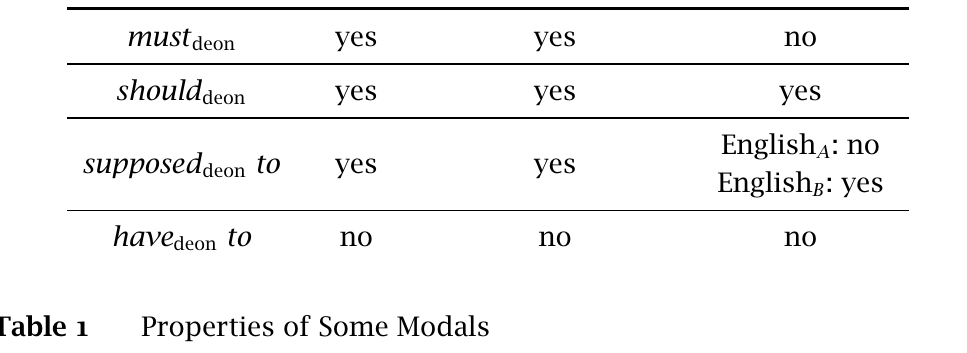
Properties of Some